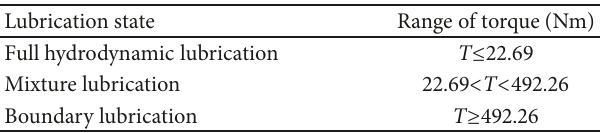
Table 6: The relationship between torque excitation and lubrication state of sliding bearing II.